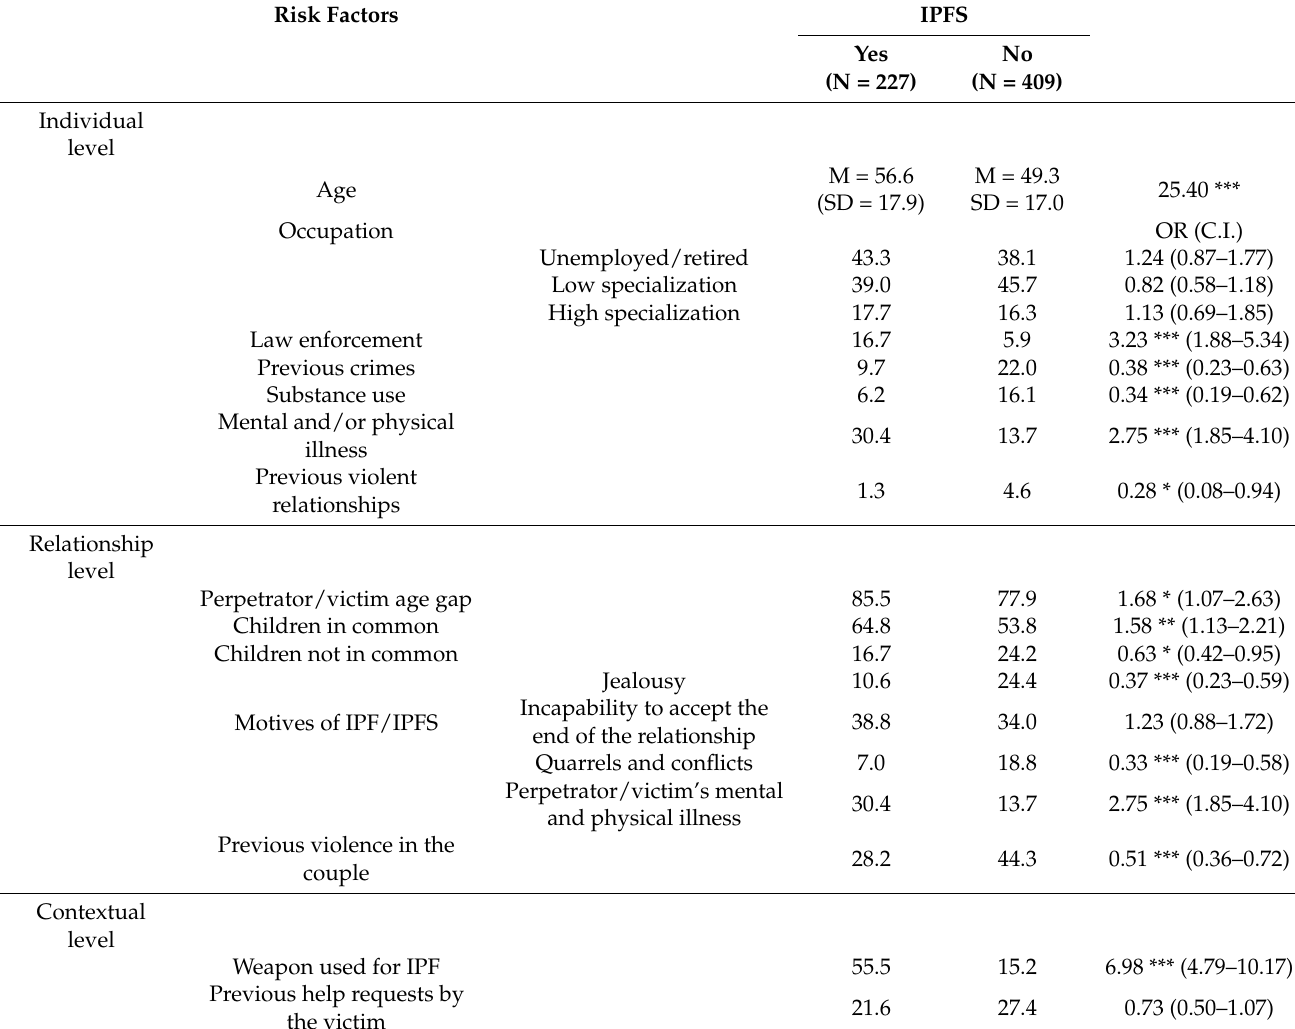
Table 2. Differences in individual, relational, and contextual risk factors between IPF and IPFS